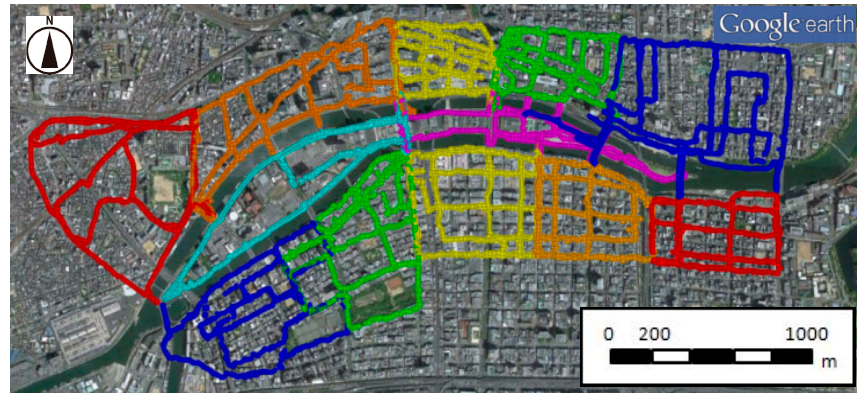
Figure 3. Travelling routes of the mobile observation started at 1400 LST, 31 August 2010. Different colors were used to distinguish adjacent subareas. The same color was used for different subareas if it was not confusing (see Figure 1c).